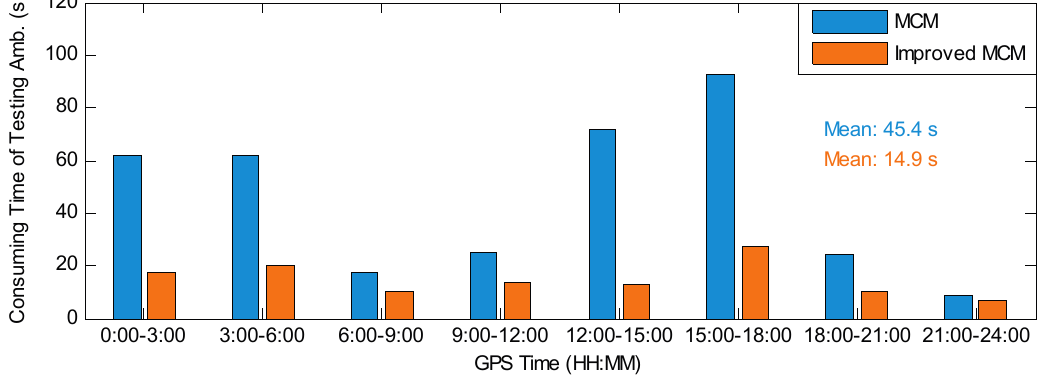
Figure 6. Computation time of testing GPS float narrow-lane ambiguity combinations in minimum constellation method (MCM) and improved MCM (IMCM) for combined GPS/GLONASS precise point positioning with fixed GPS ambiguities (GGPPP-FGA) at IGS station BJFS on 1 February